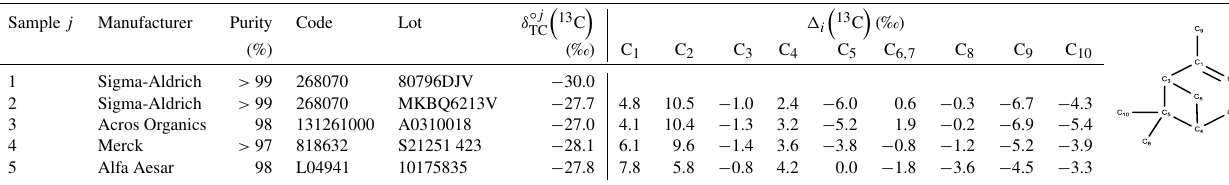
Table 1. Manufacturer information and isotopic composition of α -pinene samples. Position-specific isotopic fractionation is given as isotopic (cid:16) (cid:17) (cid:16) (cid:17) (cid:16) (cid:17) 13 C 13 C 13 C = δ i − δ ◦ j difference, (cid:49) i , of individual C atoms ( i ) in α -pinene sample j with bulk isotopic composition δ TC Listed are the means of five measurements. See inserted figure for numbering of C atoms. Sample 1 was used in the chamber experiments, but PSIA could not be performed as the sample was no longer available.